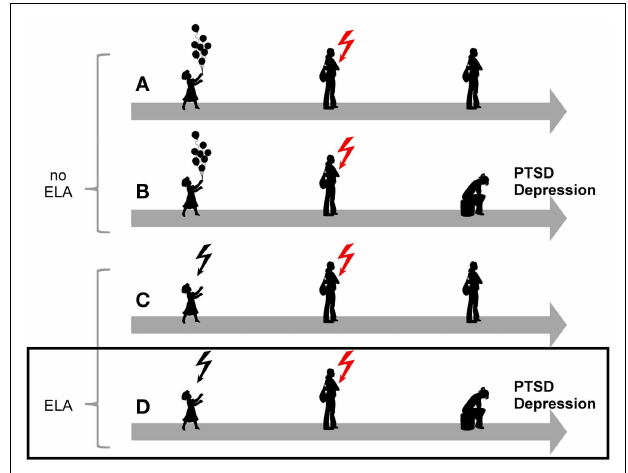
FIGURE 1 | Model for the role of early-life adversity for PTSD and depression . In the absence of a history of early life adversity (ELA), adults can be resilient to disease upon exposure to severe trauma and stress (A) while others will develop PTSD or depression (B) . Similarly, not all children exposed to early life adversity will develop disease upon anew exposure to trauma and stress (C) . On the other hand, exposure to early life adversity in childhood can give rise to a vulnerable phenotype predisposing to disease upon anew exposure to trauma and stress (D)